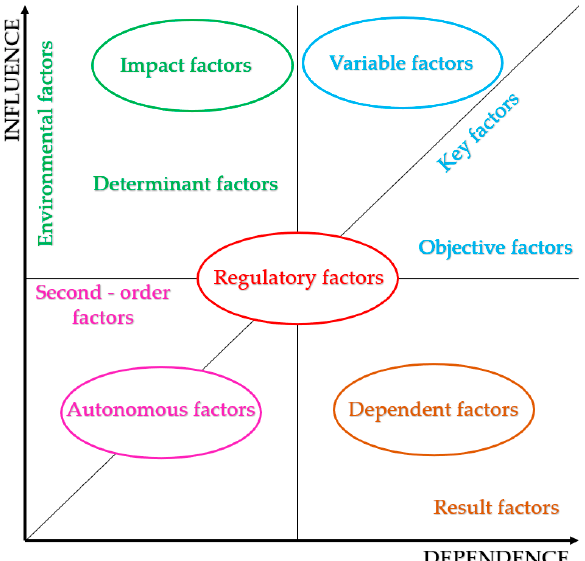
Figure 1. Map of direct influences and dependences between criteria.